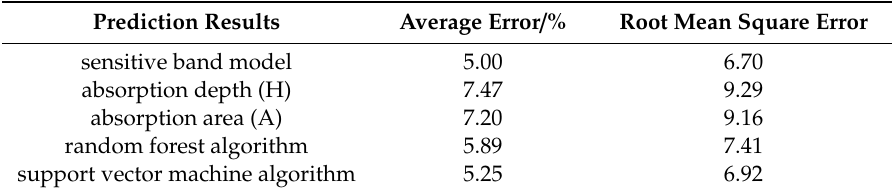
Table 7. Comparison of the prediction results of all samples for 5 di ff erent modeling